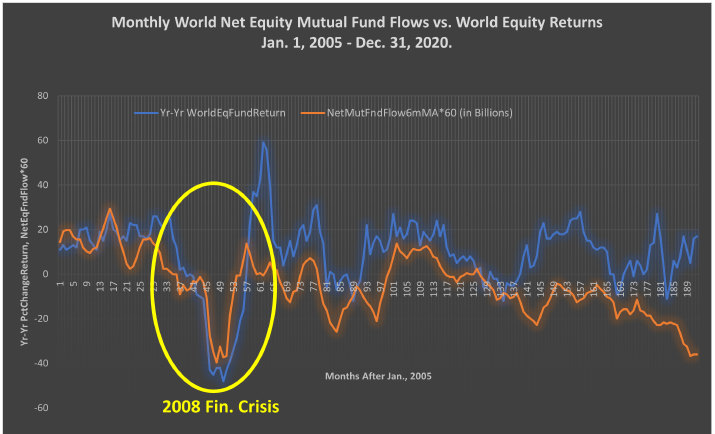
Figure 1. Net money flows into/out of world equity mutual funds are seen to be the reverse of what value investing would suggest, with flows well correlated with performance. Based on data from the Investment Company Institute (Investment Company Institute n.d.).